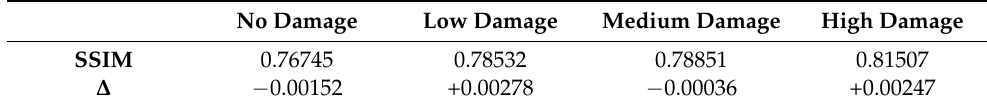
Table 19. SSIM averaged over 150 samples for a model training 20 epochs. ∆ indicates the change in the results given by ∆ = results 20 epochs − results 10